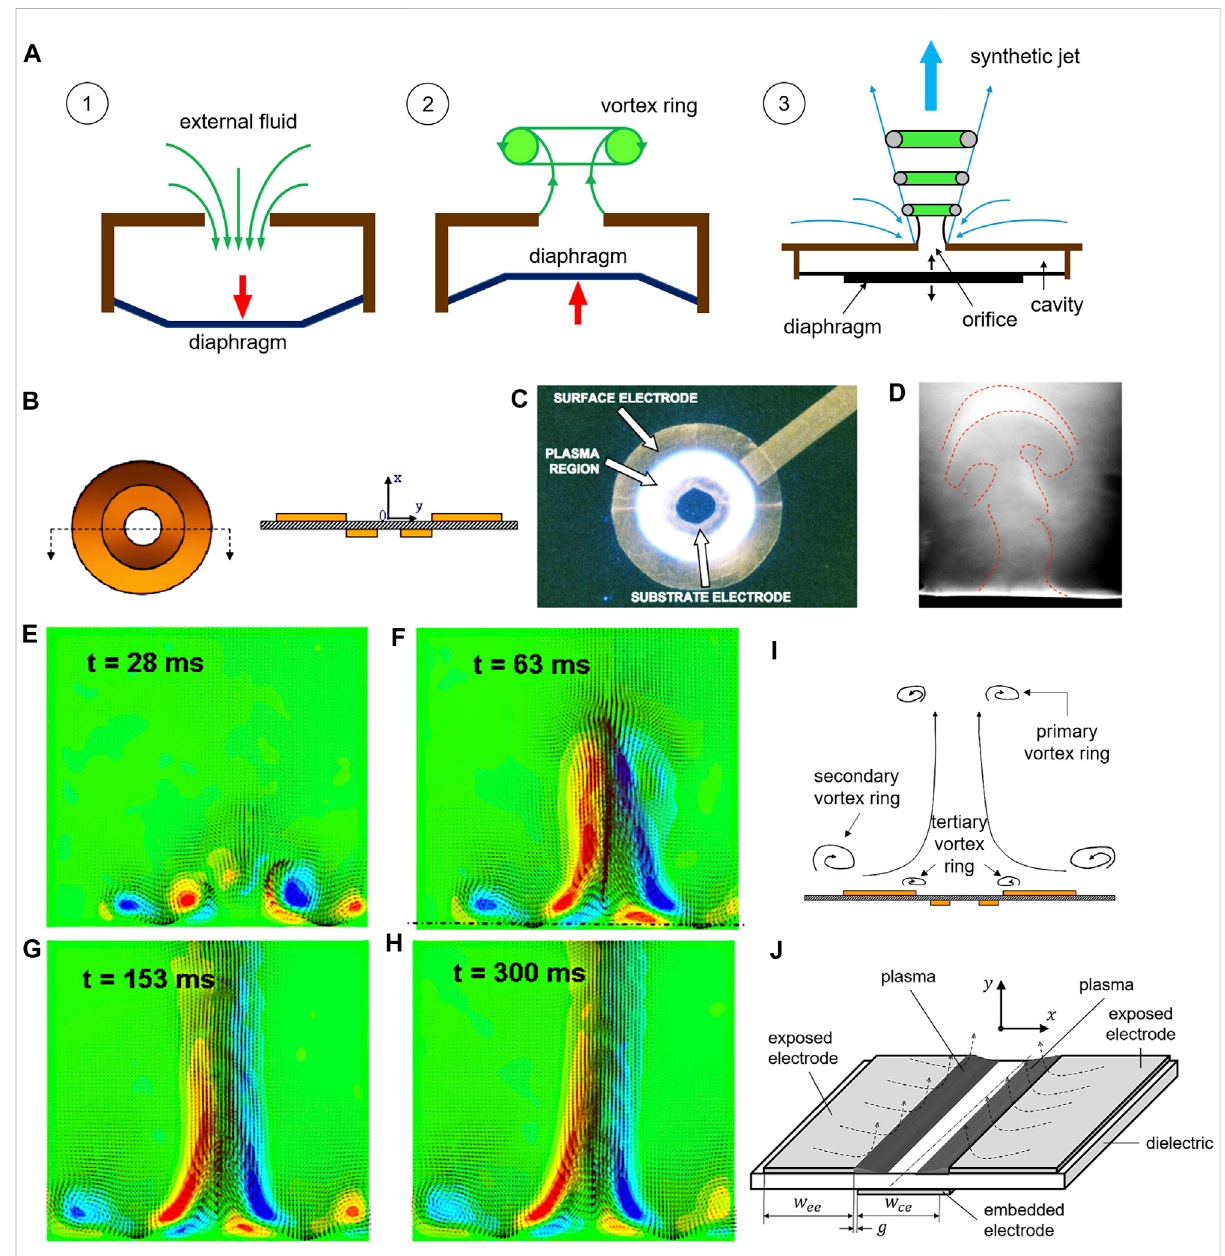
FIGURE 13 SDBD synthetic jet actuation. (A) Diagrams explaining the original mechanical synthetic jet actuators [80]. (B) Illustration of an annular SDBD syntheticjetactuatorusingconcentricringsaselectrodes. (C) Plasmaregionoftheannularsyntheticjetactuator. (D) .Schlieren fl owvisualization. (E) (F) (G) (H) Temporal evolution of the synthetic jet at t (cid:3) 28 , 63 , 153 and 300 ms, respectively. (I) Summary of the fl ow structures that develop in the SDBD synthetic jet. (J) Illustration of a linear SDBD synthetic jet actuator [82,